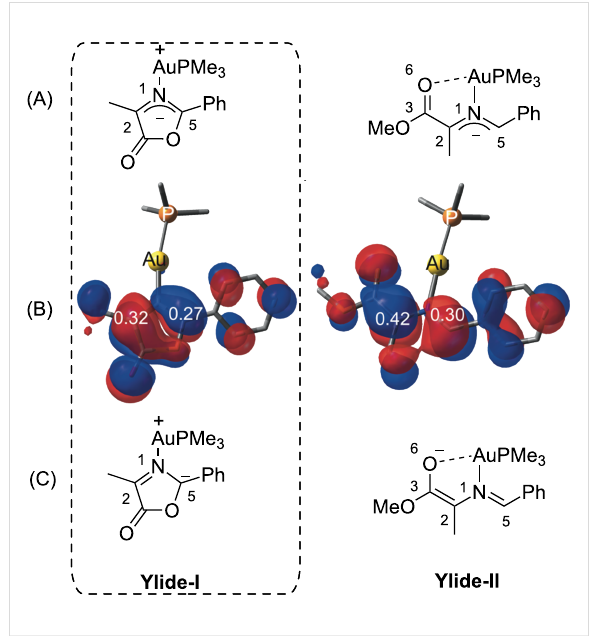
Figure 5: (A) Schematic representation of the model gold(I) ylides. (B) HOMO of the ylides and expansion orbital coefficient values of carbon atoms 2 and 5 computed at HF/Lanl2dz level of theory. Hydrogen atoms are omitted for clarity. (C) Most stable Lewis structures of the ylides obtained with the Natural Resonance Theory (NRT)